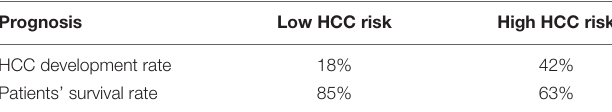
TABLE 1 | Summary of the clinical parameters associated with each group of cirrhotic livers.